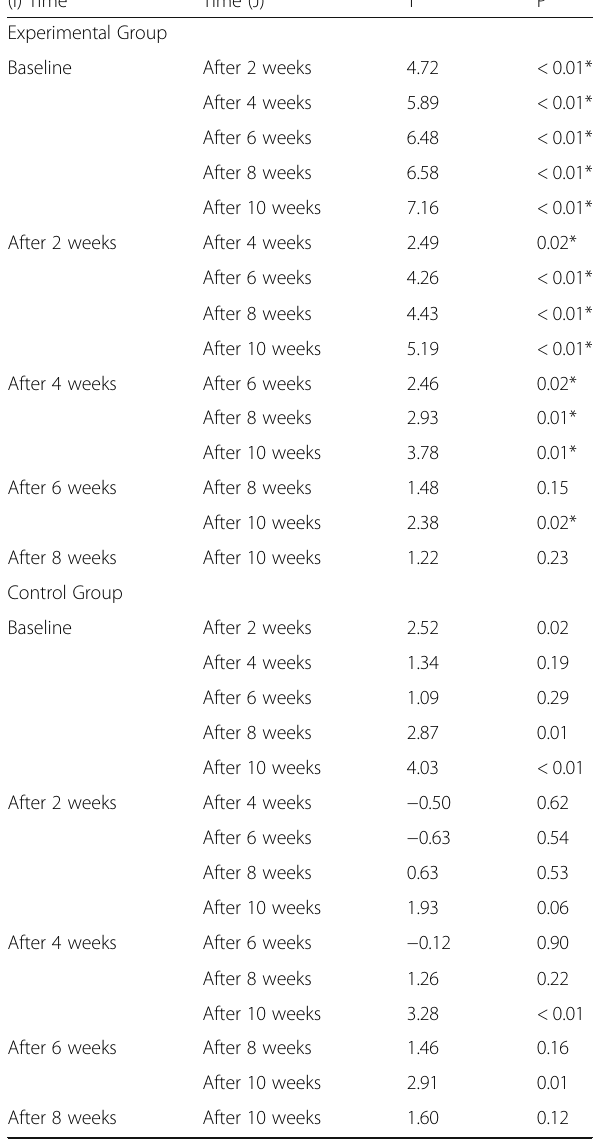
Table 5 Paired t test showing pair-wise comparison of pain level in each group across 10